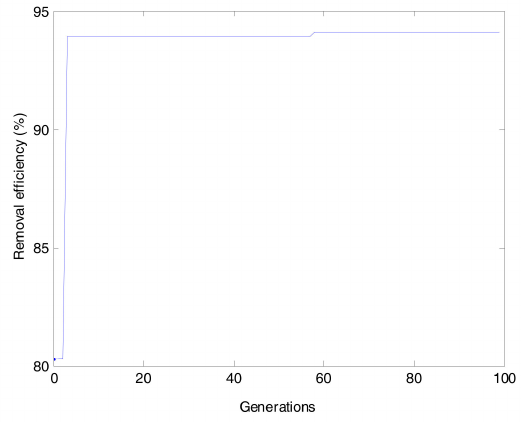
Figure 16. Evolvement of fitness with 100